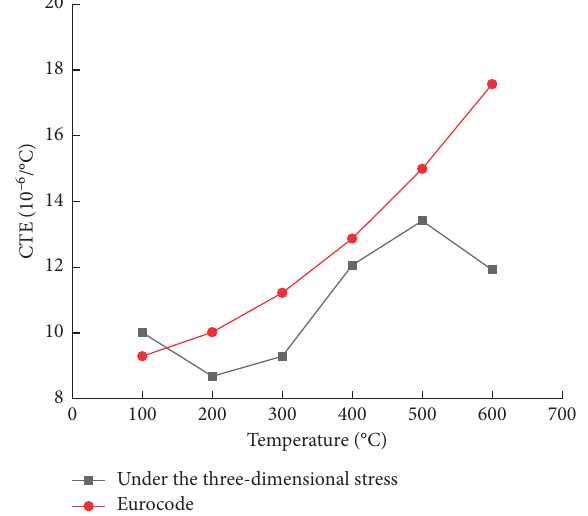
Figure 6: Comparisons of the CTE under different